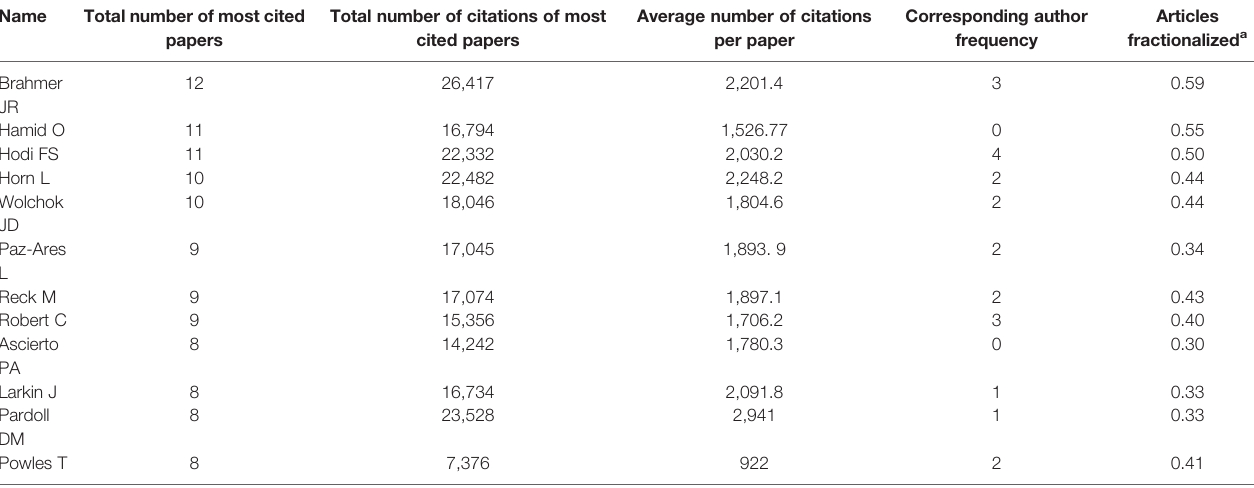
TABLE 3 | Authors of at least eight of the top-cited papers on anti-PD1/PDL1 immunotherapy for cancers.